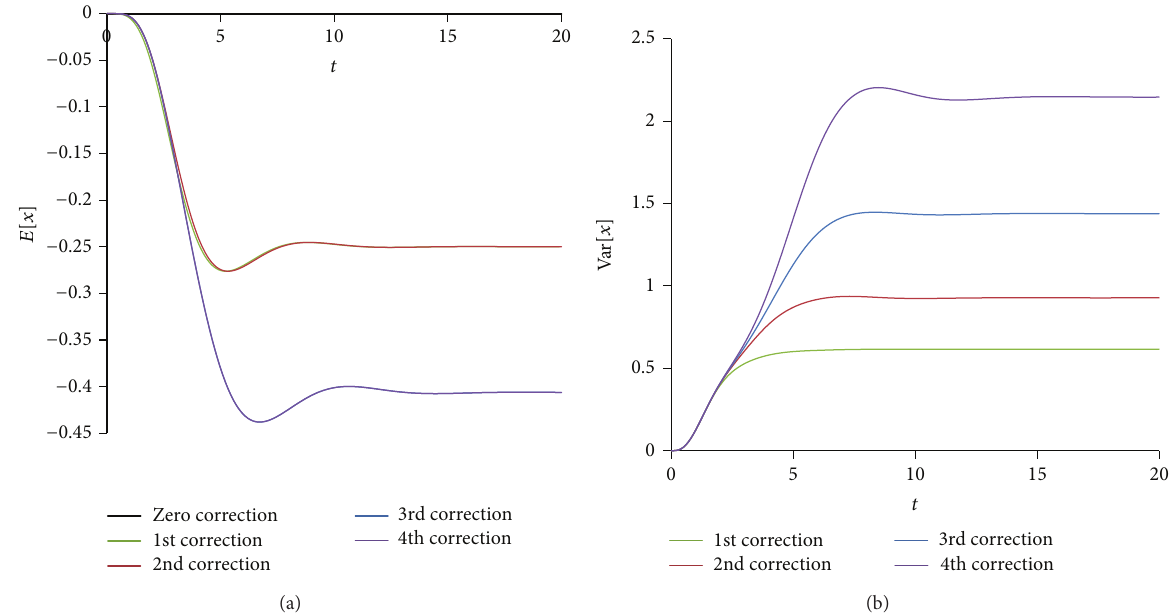
Figure 9: The second-order response mean and variance for 𝜀 = 0.5 and time interval of 20